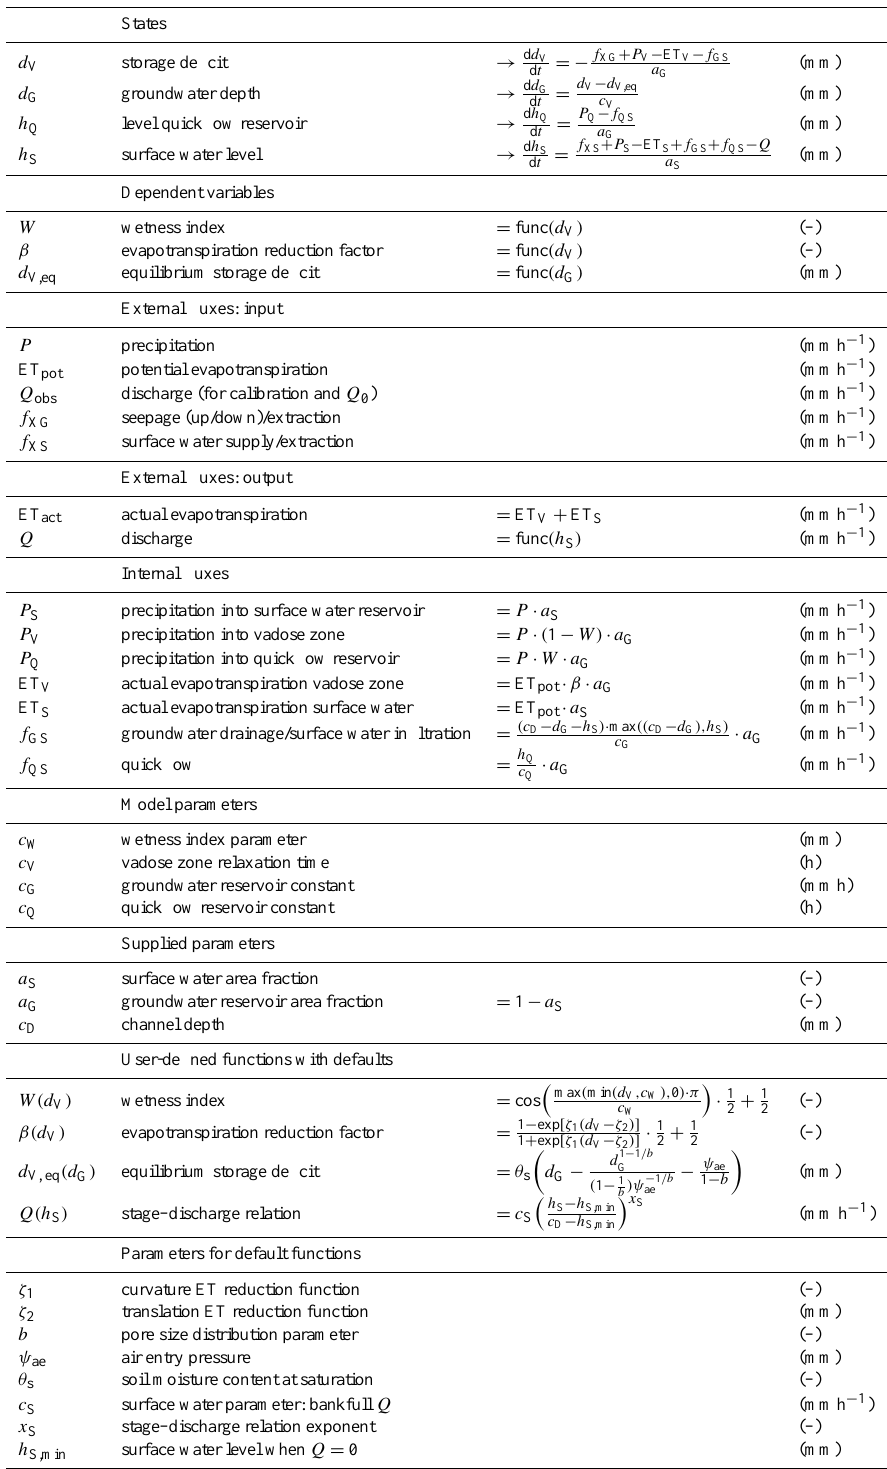
Table 1. Overview of variables, parameters and functions. All fluxes are catchment averages, both external ones (including Q and f XS ) and internal fluxes (which are multiplied with the relative surface area of the reservoir in question). Note that d V , h Q and h S result from the mass balances in the three reservoirs, while d G is only used as pressure head to compute the groundwater drainage flux. The names of the fluxes are derived from the reservoirs (for example f XS : f stands for flow, the X for external and the S for surface water – water flowing from outside the catchment into the surface water